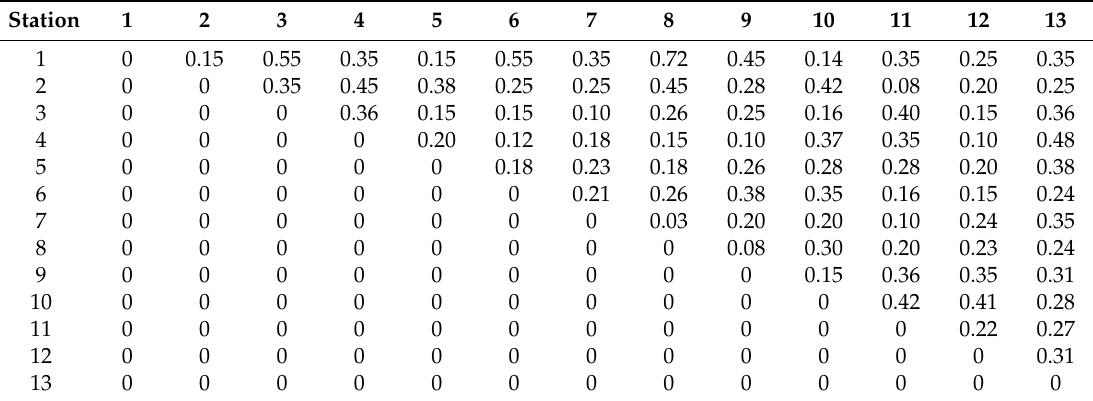
Table 3. Passenger flow arrival rate at downstream direction of Batong Line. Unit: pax · s − 1